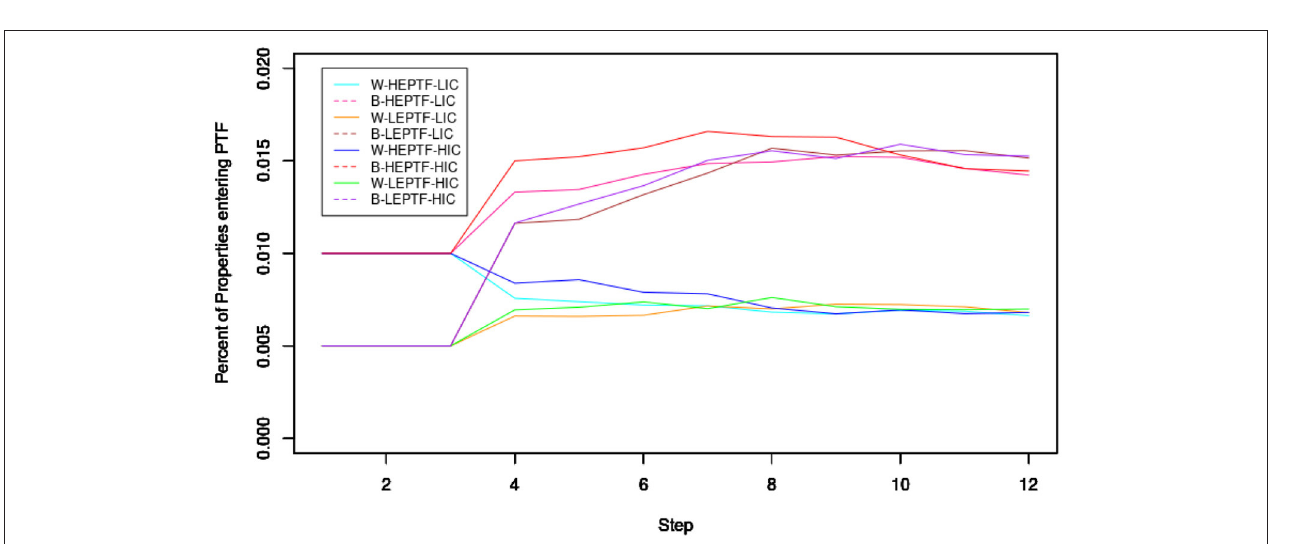
FIGURE 2 | Neighborhood simulation. The Y-axis indicates the total proportion of properties that have experienced Property Tax Foreclosure in that step and the X-axis indicates the step number (e.g., 0.2 on the y-axis means 20%). W indicates that scenario is for a neighborhood that is 50% White, while B indicates the scenario is for a neighborhood that is 0% White. LEPTF indicates that the scenario is for a neighborhood that has a lower number (30) of initial Property Tax Foreclosures. HEPTF indicates that the scenario is for a neighborhood that has a higher number (60) of initial Property Tax Foreclosures. H/L IC indicates that a simulation had a high or low initial concentration of Property Tax